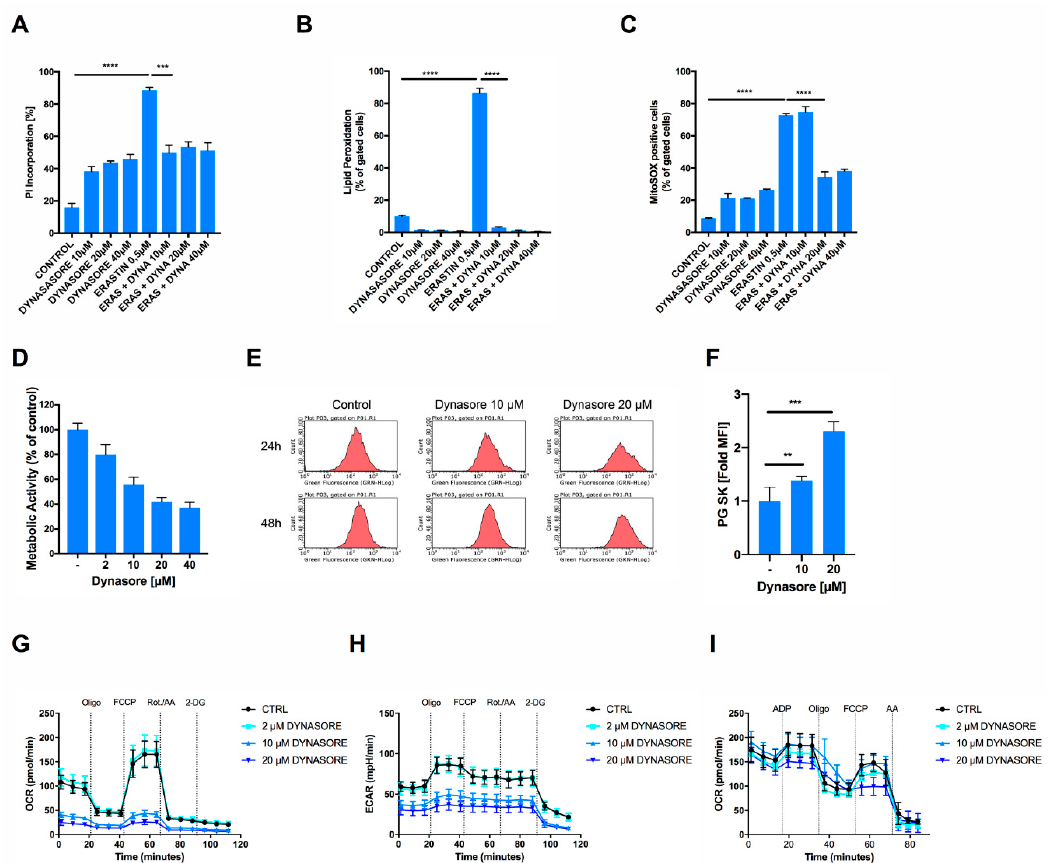
Figure 3. Dynasore protects neuronal cells from ferroptosis and inhibits mitochondrial respiration. ( A , B ) HT22 cells were treated with DMSO and with the indicated concentrations of dynasore and erastin (0.5 µM) for 16 h. Cell death was determined by AnnexinV/PI staining and fluorescence-